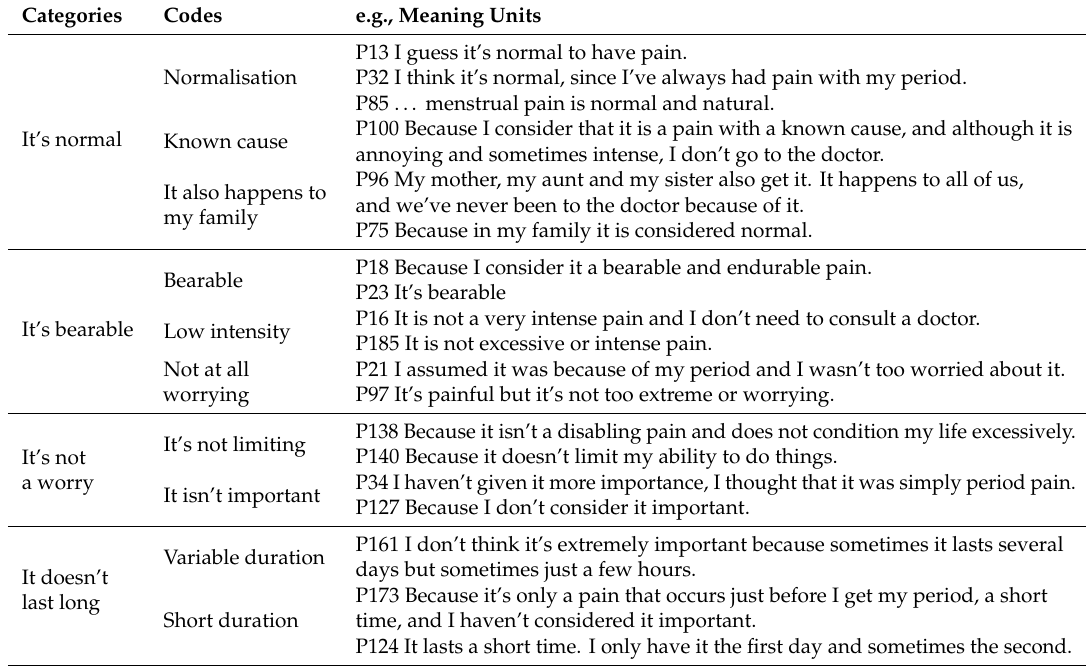
Table 3. Categories, codes, and examples of the theme “underestimation of